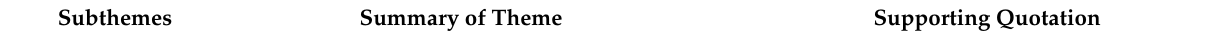
Table A2. Patterns of COVID-19 impact by age, comparing participants over and under 55